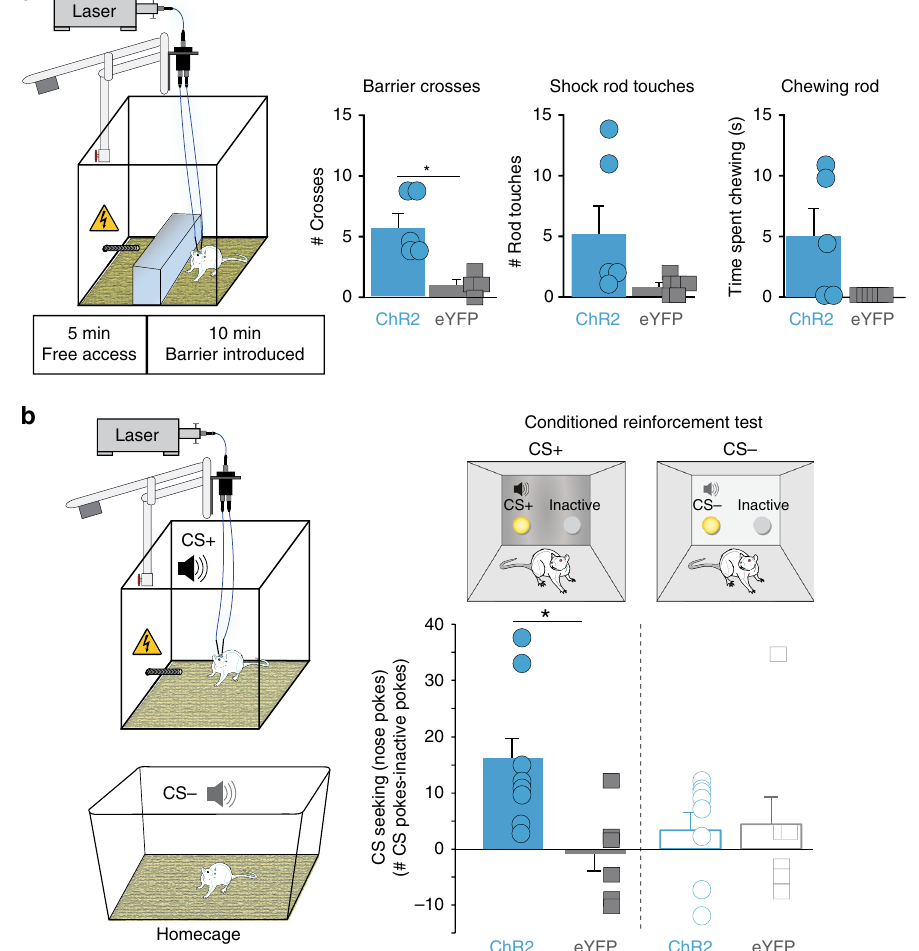
Fig. 4 CeA ChR2 shock-rod attraction enhances shock-rod ‘ seeking ’ and cue incentive salience. a Apparatus shows novel opaque barrier interposed between rat and shock rod after 5 min into session. Number of barrier crosses to reach shock rod (ChR2 rats, N = 5 vs. eYFP rats, N = 5, two-sided unpaired t -test: t 8 = 3.0, p = 0.02, d = 2.04). Number of shocked touches on shock rod: two-sided unpaired t -test: t 8 = 1.1, p = 0.08. Time spent chewing on shock rod: two-sided unpaired t -test: t 8 = 1.1, p = 0.08. b Instrumental conditioned reinforcement test. Rats nosepoked to earn presentations of auditory conditioned stimulus (CS) + previously paired with shock-rod encounters (top) or a different auditory CS − previously paired with homecage. Right graph depicts CS + seeking as difference score between the number of nosepokes to earn CS + sound (shock-rod-paired CS) over the number of nosepokes in inactive hole that earned nothing. Left depicts CS − seeking: the number of nosepokes to earn CS − (homecage sound) sound over the number of nosepokes in inactive hole. CS + vs. CS − were tested in separate sessions. Difference score for each day (CS nosepokes − inactive nosepokes) during CS + and CS − sessions (ChR2 rats, N = 8, eYFP rats, N = 6 ; two-way repeated measures ANOVA, CS type × virus interaction: F 1,12 = 3.84, p = 0.04; CS + :